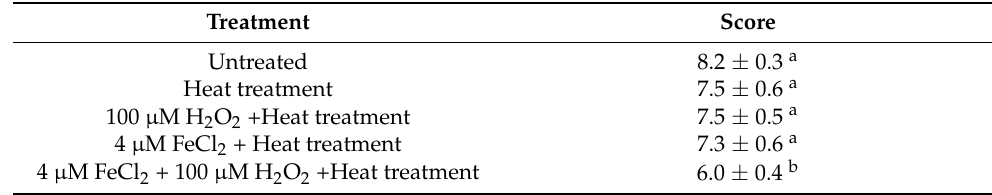
Table 4. Effect of H 2 O 2 on Fe 2+ -mediated aroma deterioration in catechins-removed green tea